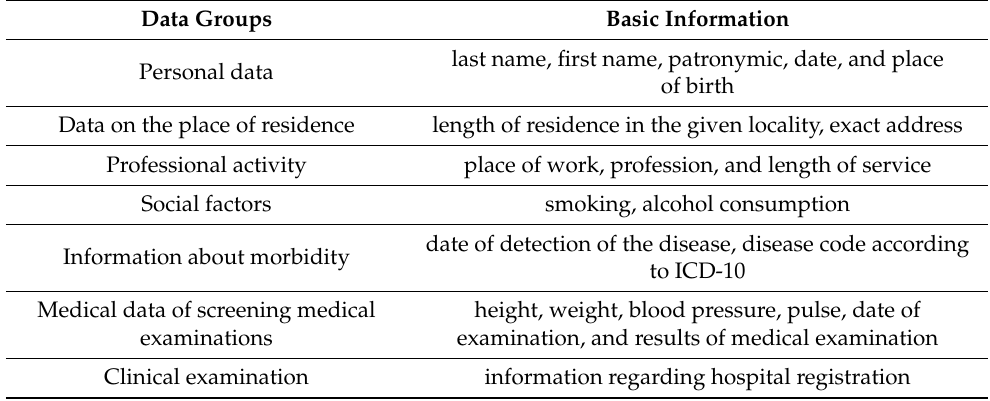
Table 2. Data of the population living in the Syrdarya uranium ore